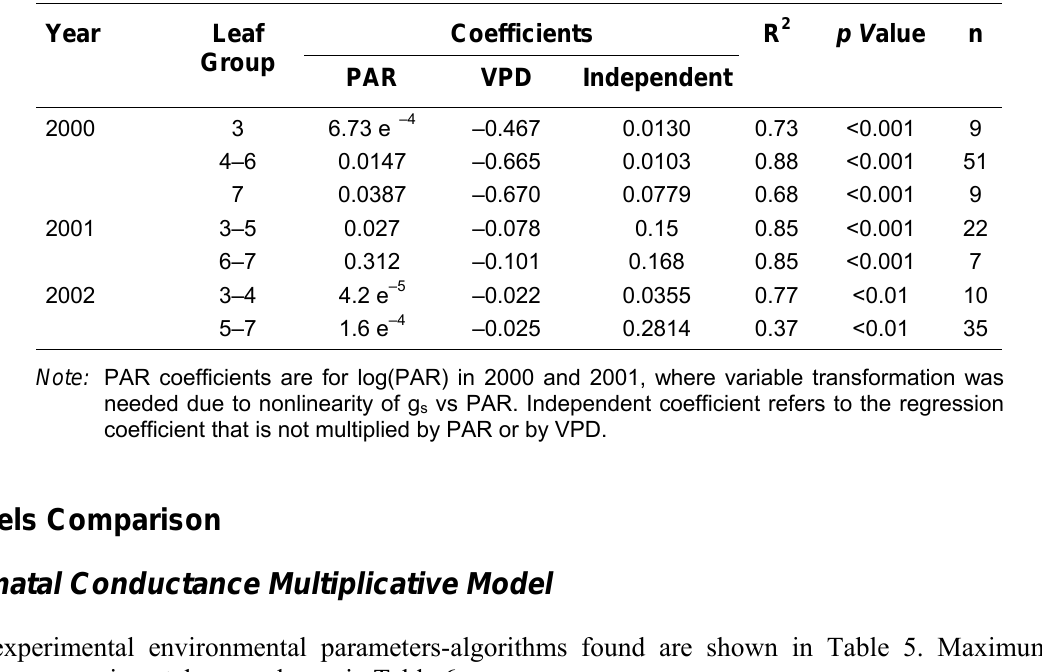
as a Function of PAR and s